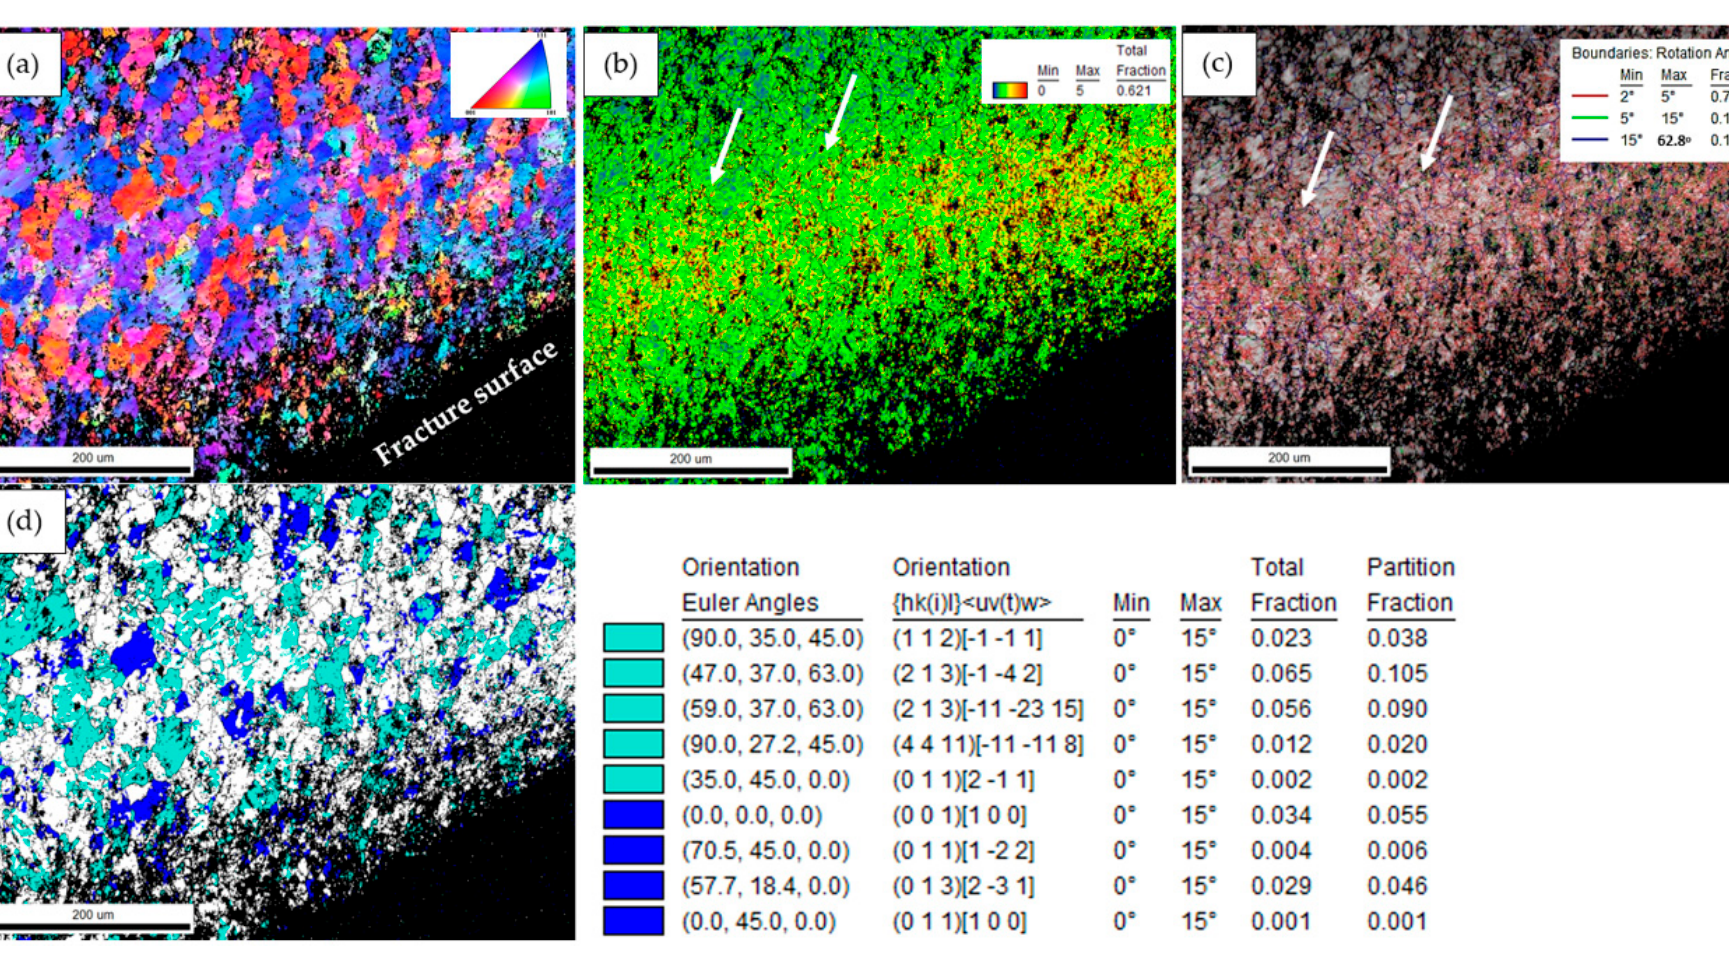
Figure 9. Indicative scan of sample rx.RD which was accomplished at lower magnification to detect the areas of interest (indicated by the black arrow). ( a ) IPF map, ( b ) KAM map, ( c ) misorientation angle map and ( d ) map illustrating the crystallographic components (light blue: rolling components and dark blue: recrystallization components).